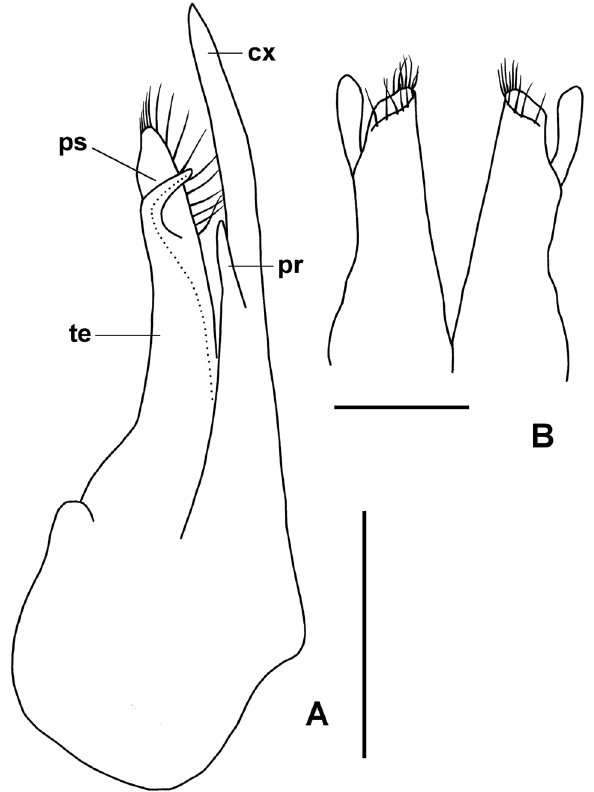
Figure 13. Equestrigonus tasmaniensis gen. n., sp. n., QVM 23:54467. A Anterior and slightly medial view of left anterior gonopod; cx = coxite, pr = small process on coxite, te = telopodite, dotted line indi- cates prostatic groove ending on pseudoflagellum (ps) B Posterior view of posterior gonopods. Scale bars: A = 0.5 mm, B = 0.25